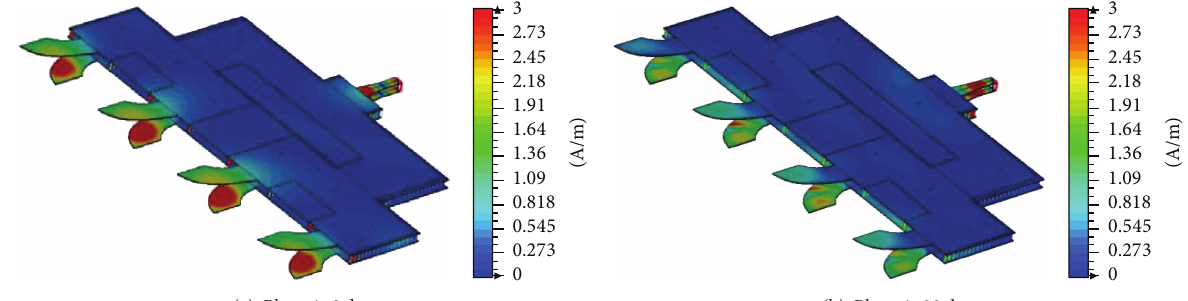
Figure 22: Surface current of the SIW Vivaldi antenna array.